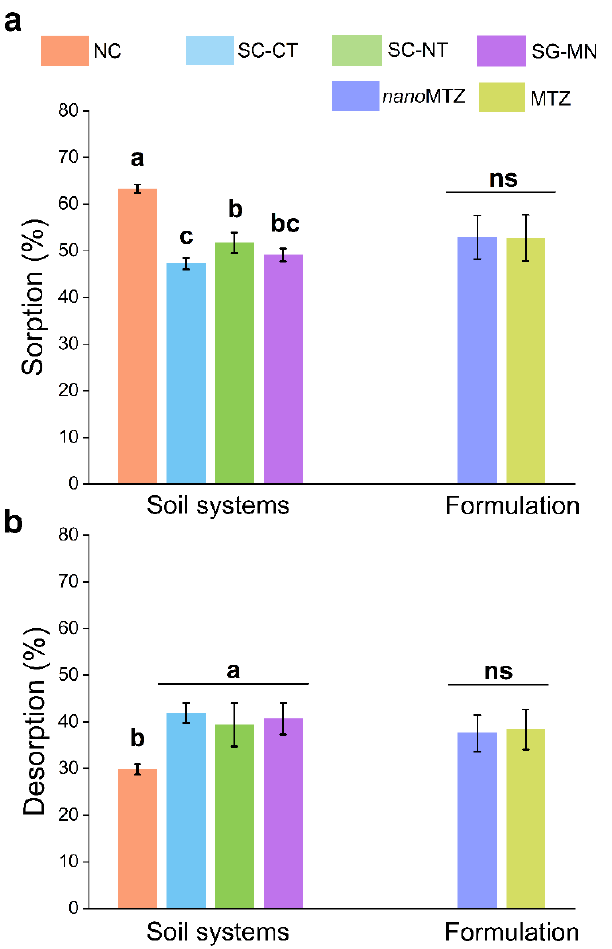
Figure 1. Sorption ( a ) and desorption ( b ) percentages for nanoMTZ and conventional MTZ in different soil systems (non-crop soil — NC, cultivated soil with soybean – corn succession in a no-tillage system — SC-NT, cultivated soil with soybean – corn succession in a conventional tillage system — SC-CT, and sugarcane monoculture soil — SG-MN). Bars represent the standard error of the mean ( n = 2). Since the interaction between soil system and formulation is not significant, lowercase letters differ between soil systems (regardless of formulation) and ns indicates no differences between formulations by Tukey ’ s test ( p < 0.05).